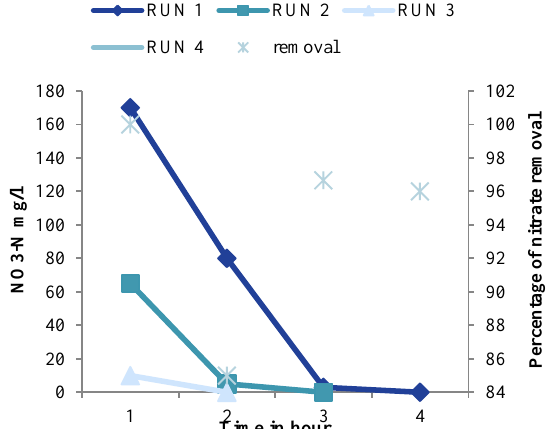
Figure 6. Nitrate concentration in the influent and effluent of the nitrification granular activated carbon up-flow submerged reactors (NGAC-USR) and the percentage of nitrate removal throughout the study